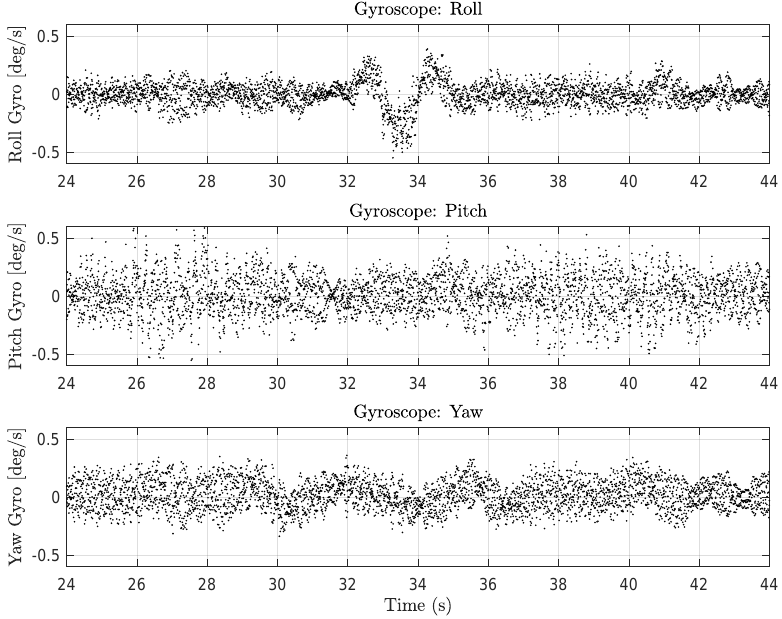
Figure 7. Raw gyroscope data from t5_00 . Vibrations from UAV propellers create noisy gyroscope data. Differentiating this noisy data creates the high-frequency magnetic noise seen in Figure